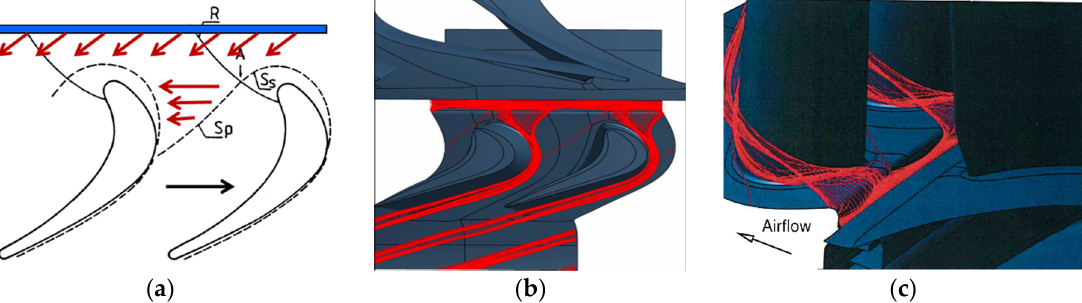
Figure 5. Skewed flow due to rotational effect : ( a ) schematic of cascade inlet flow condition and ( b ) simulated streamlines issuing from a stator to rotor gap from Green et al., 2012, side view—not to be scaled as reported in [33] (c) simulated streamlines issuing from a stator to rotor forward looking after side view—not to be scaled as reported in [33].